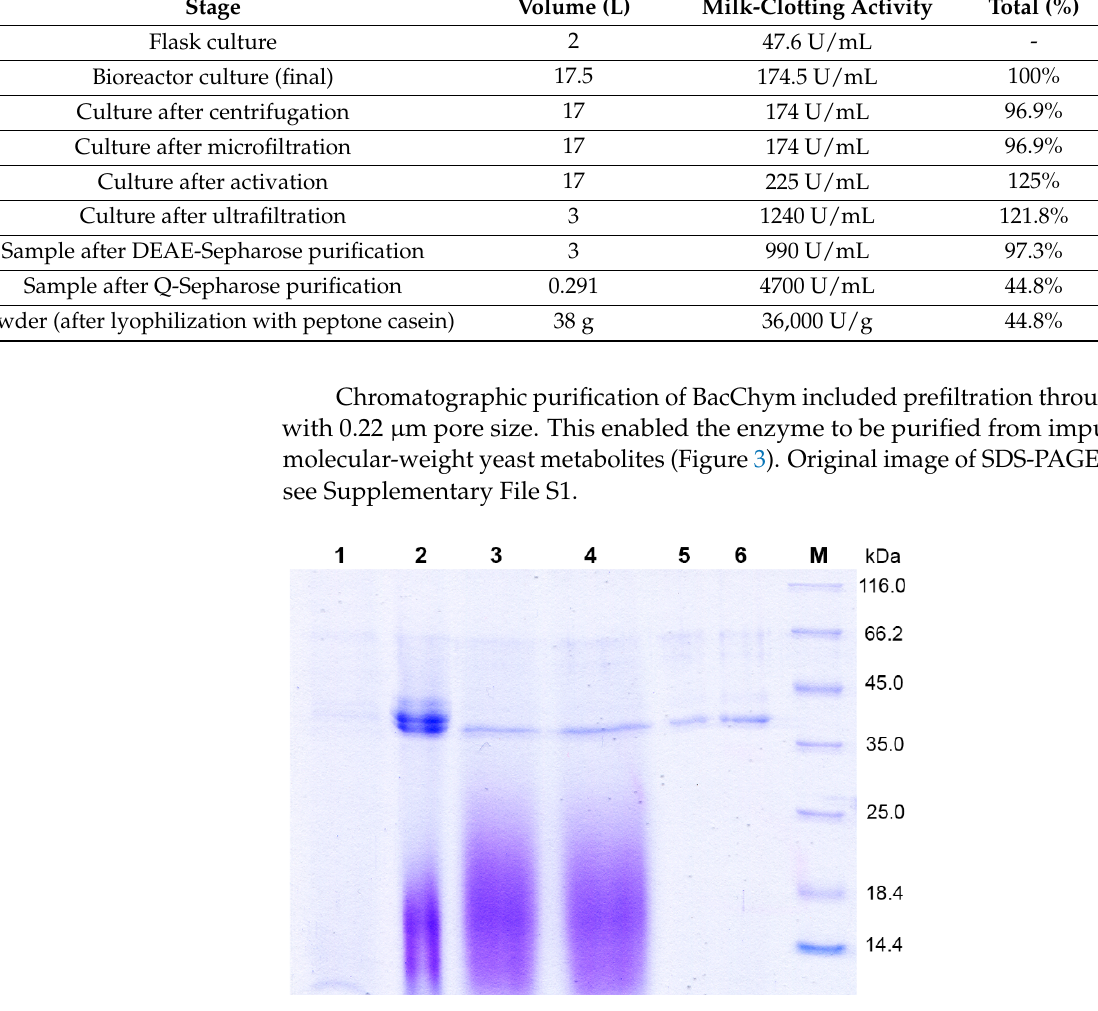
Table 1. Data on enzymatic activity at all stages of preparation of the BacChym.